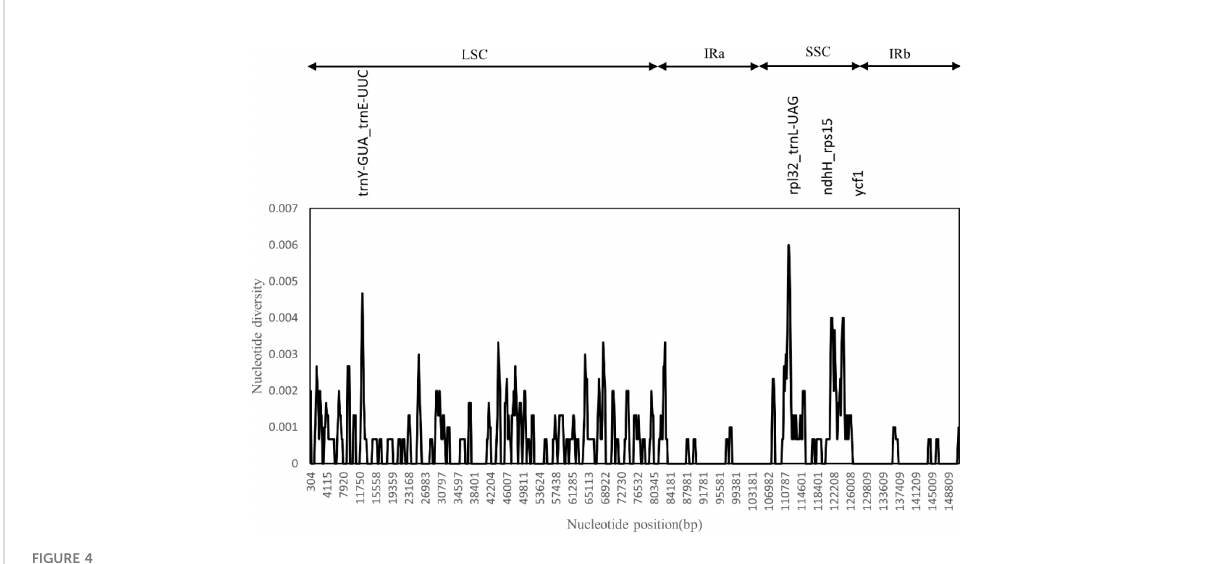
FIGURE 4 Sliding window test of nucleotide diversity (Pi) in the multiple alignments of the fi ve Artemisia cp genomes. Peak regions with a Pi value of >0.004 were labeled with loci tags of the genic or intergenic region names. Pi values were calculated in the 600 bp sliding windows with steps